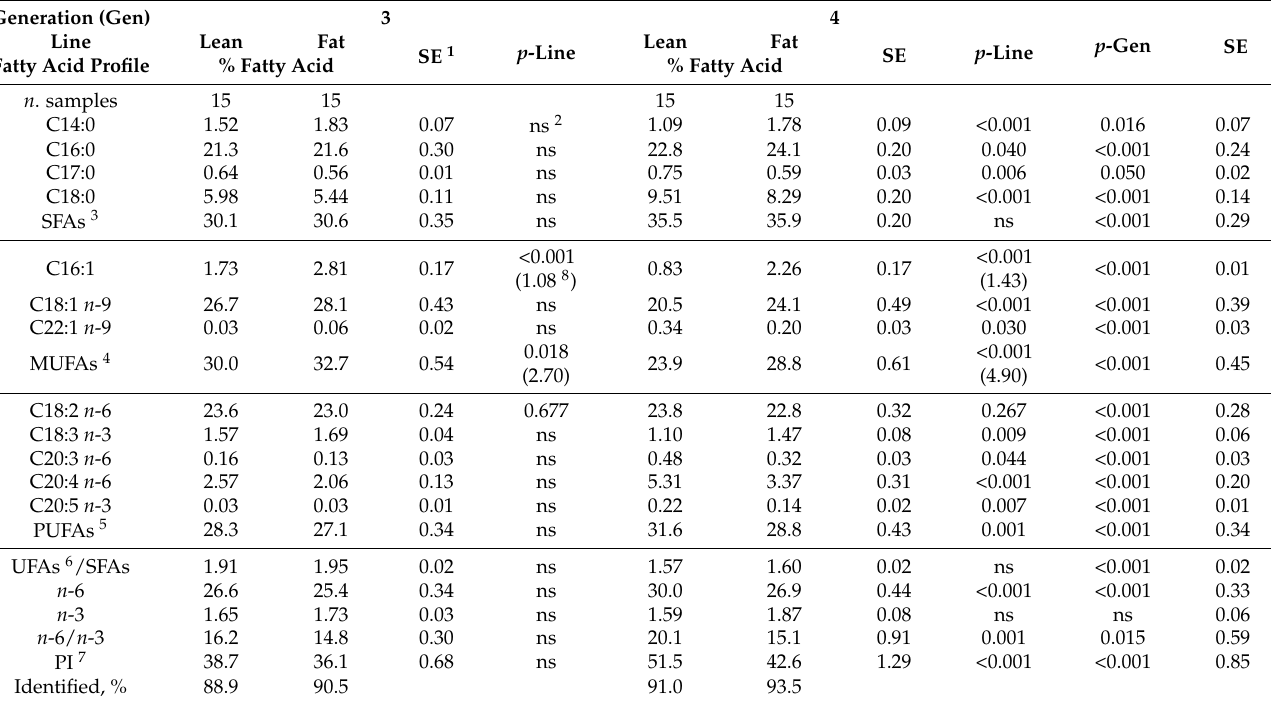
Table 2. Fatty acid profile (% of total FAMEs) of the longissimus thoracis et lumborum of Lean and Fat rabbits in third and fourth generations of divergent selection for total body fat